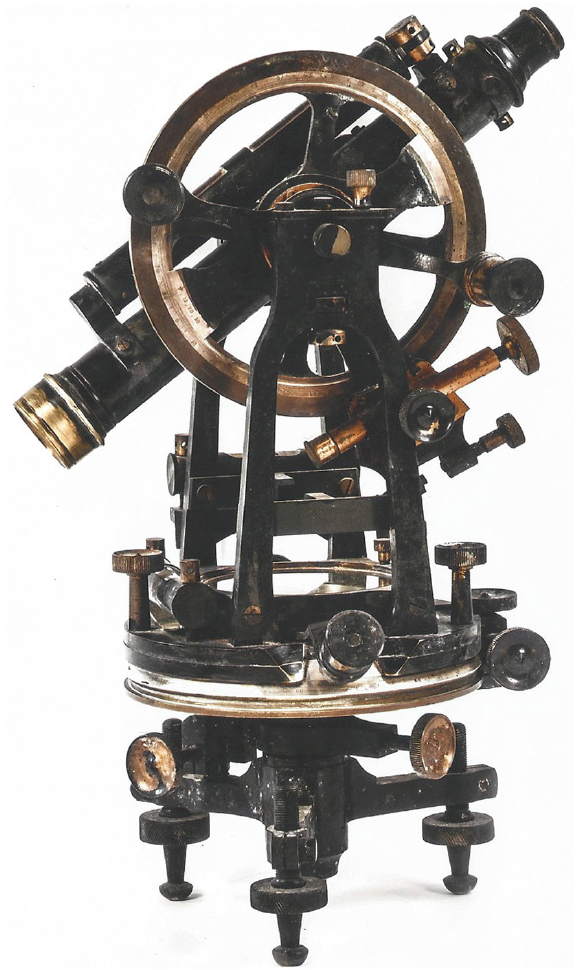
Figure 9. The Kew declinometer designed by Elliott Brothers was installed in 1870, but started recording in January 1871, which con- tinued till 1906. It had a magnet and two mirrors with a vertical and horizontal scale (courtesy of Colaba–Alibag